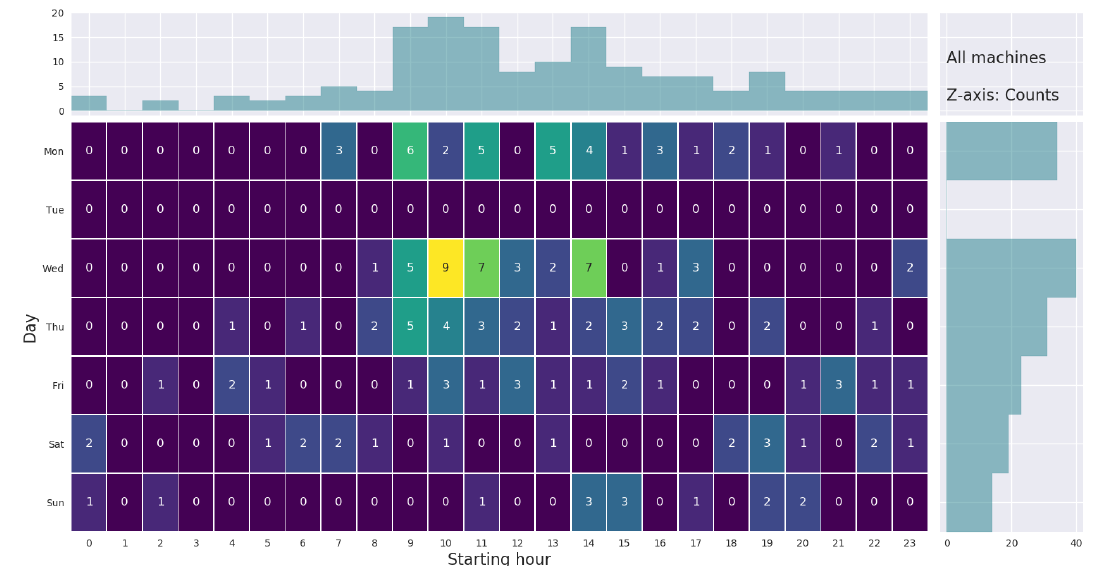
Figure 17. Heatmap of downtime at MAX IV as a function of days and start hour for all three machines (I, R3, R1).